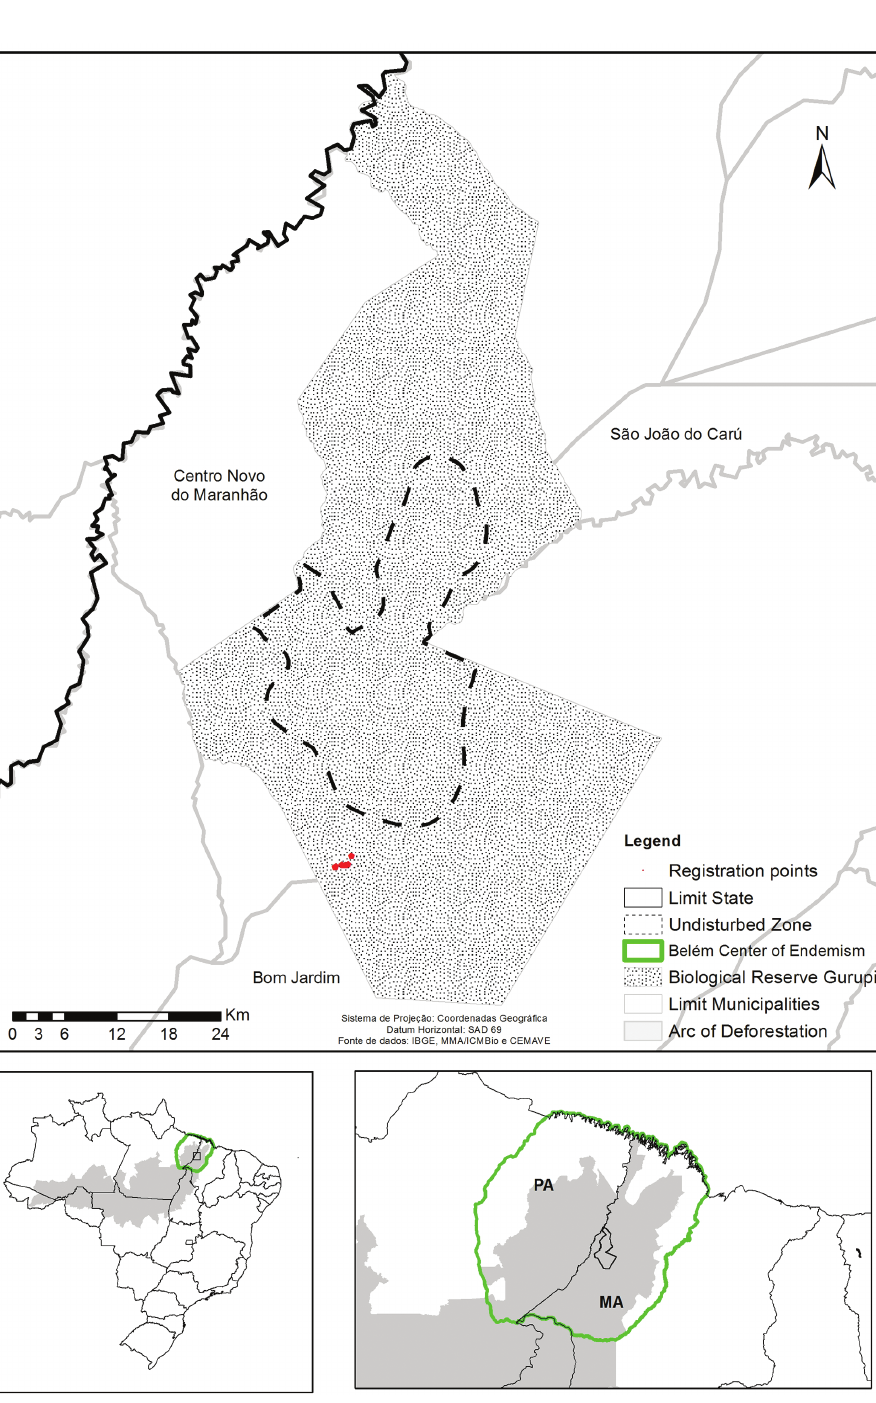
Figure 1. Map with the location of the study area, in the Gurupi Biological Reserve, Maranhão,